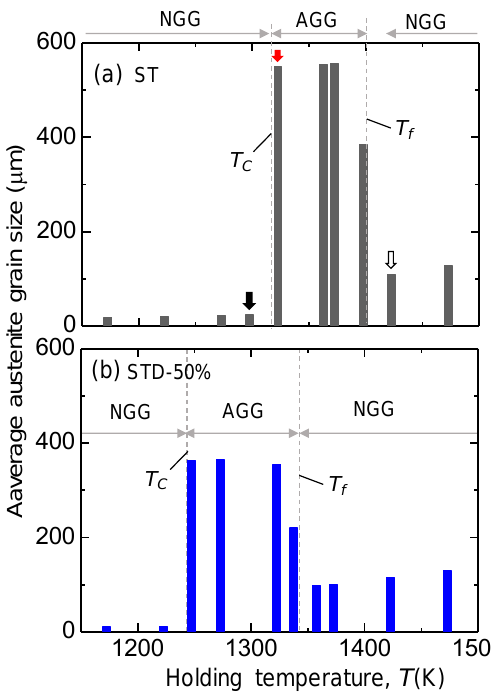
Figure 3. Average prior austenite grain sizes of the ( a ) ST and ( b ) solution-treated and cold-deformed by 50% (STD-50%) specimens after annealing at various temperatures for 1800 s.